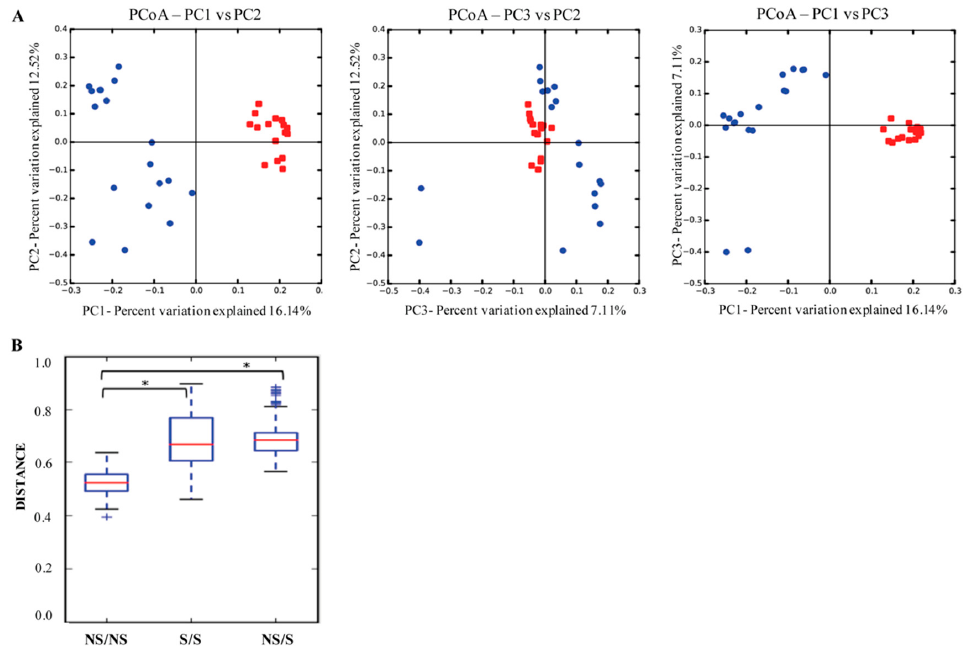
Figure 1. Clustering of samples from nonsmokers and smokers. ( A ) for beta diversity, principal coordinate analysis plots (PCoA) based on unweighted UniFrac distance were used to visualize the variation present in all samples by smoking status. Emperor web browser was used to perform the analysis. Significant cluster was observed in the saliva microbial community among smokers (blue dots) and nonsmokers (red dots). ( B ) unweighted UniFrac plot representing the intraindividual variability within nonsmokers (NS) and smokers (S). The asterisks (*) indicate a significant difference (nonparametric p -value with Bonferroni correction), where p =